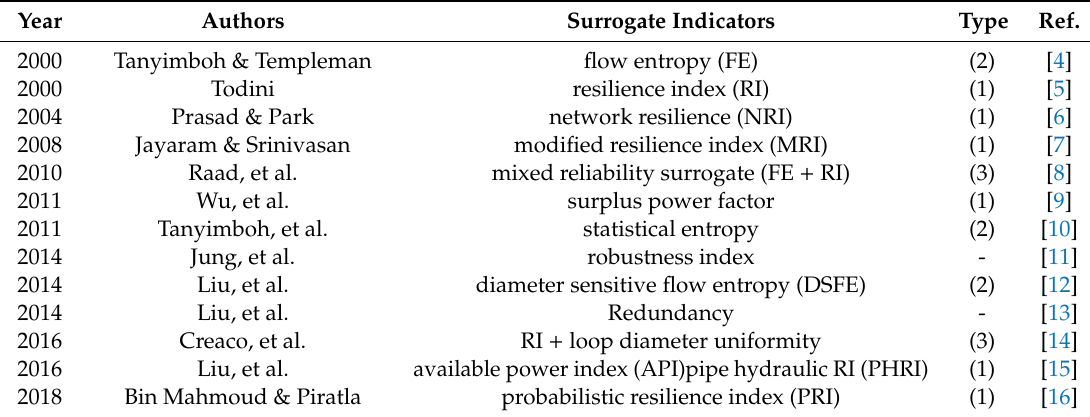
Table 1. Surrogate indicators for measuring WDS reliability in the